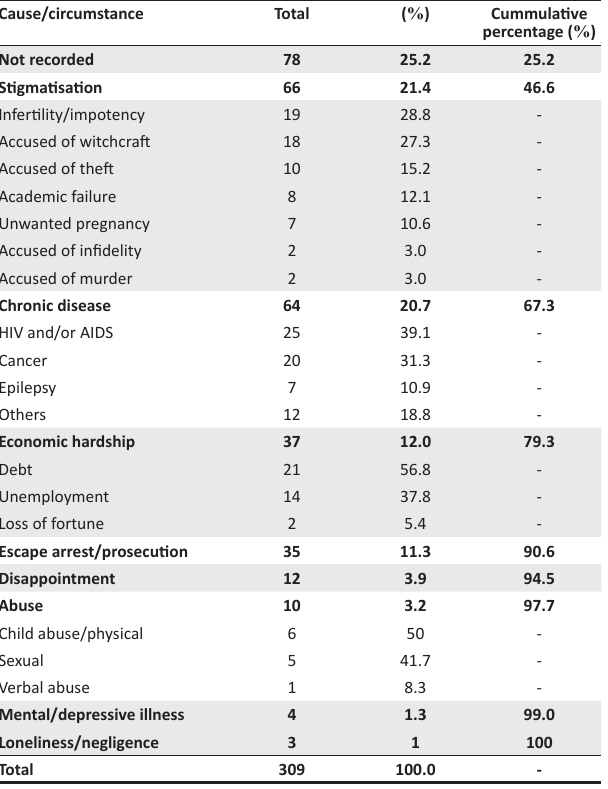
TABLE 3: Alleged circumstance or reason for committing suicide.